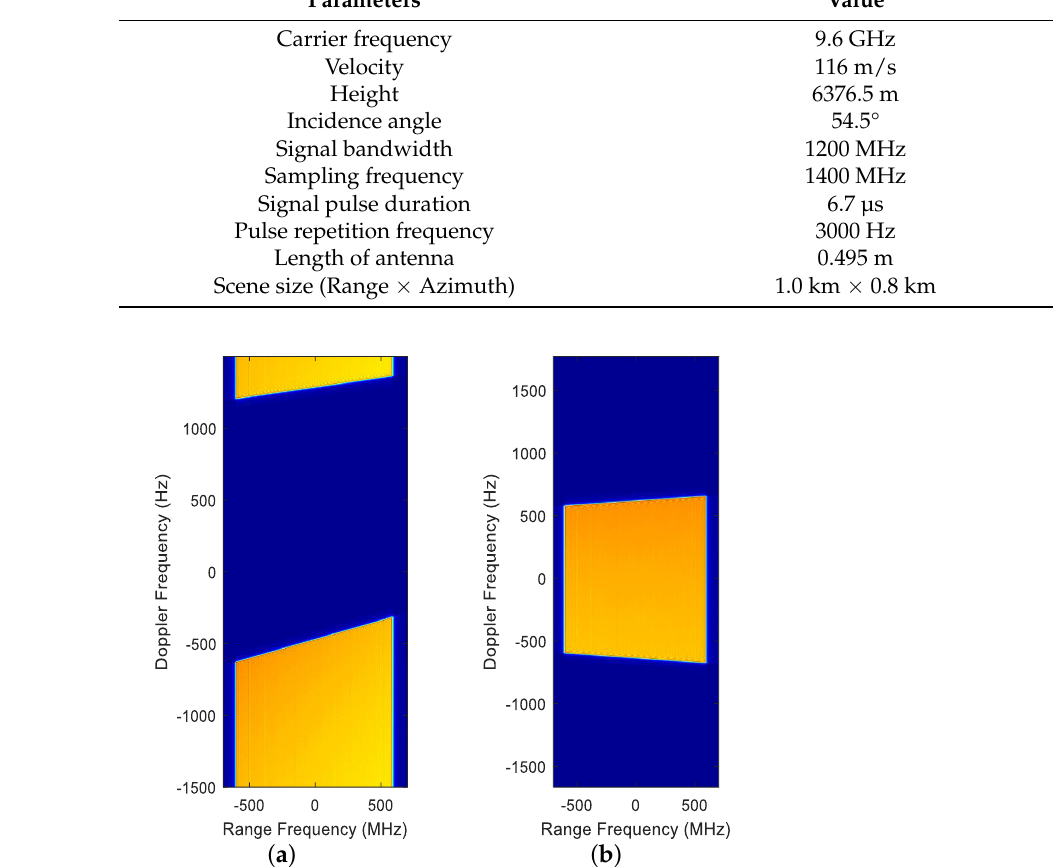
Figure 2. 2 − D spectrum resulting from IETSA ( a ) before and ( b ) after azimuth resampling, with a squint angle of 15° and a coherent integration angle of